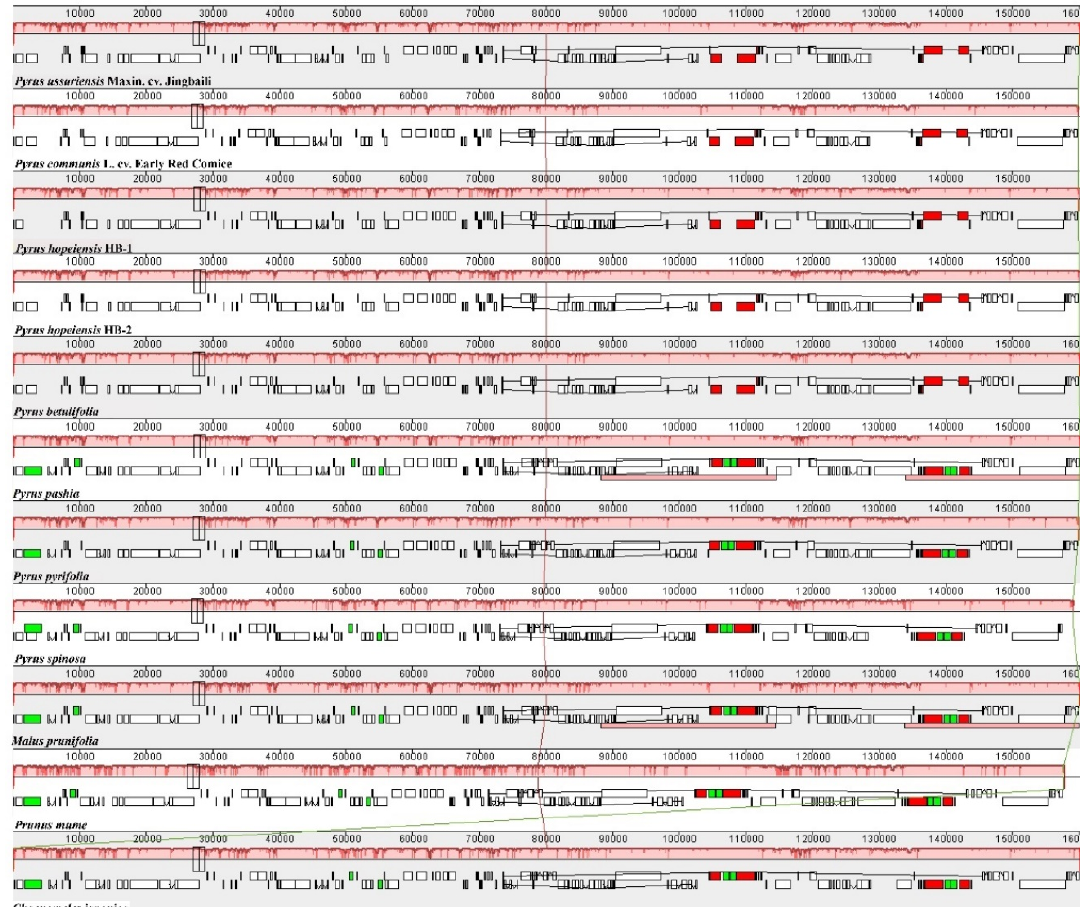
Figure 5. Co-linear analysis of various plant chloroplast genomes.